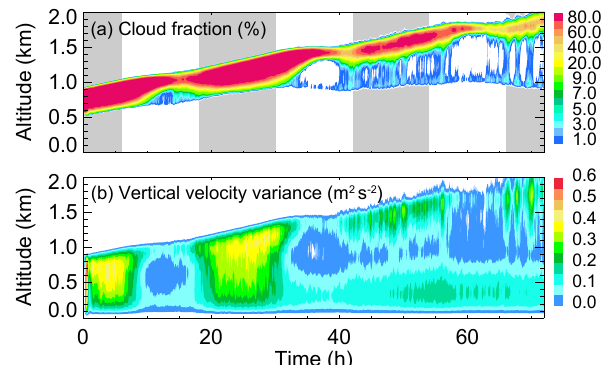
Figure 1. Evolution of horizontal average profiles of (a) cloud fraction (defined by a cloud water mixing ratio threshold of 0.01gkg − 1 ) and (b) vertical velocity variance for the lightly driz- zling baseline case ( N a , sulfate = 150mg − 1 ). The simulation starts at midnight local time. Gray shading indicates nominal nightime (06:00pm ∼ 06:00am local time).